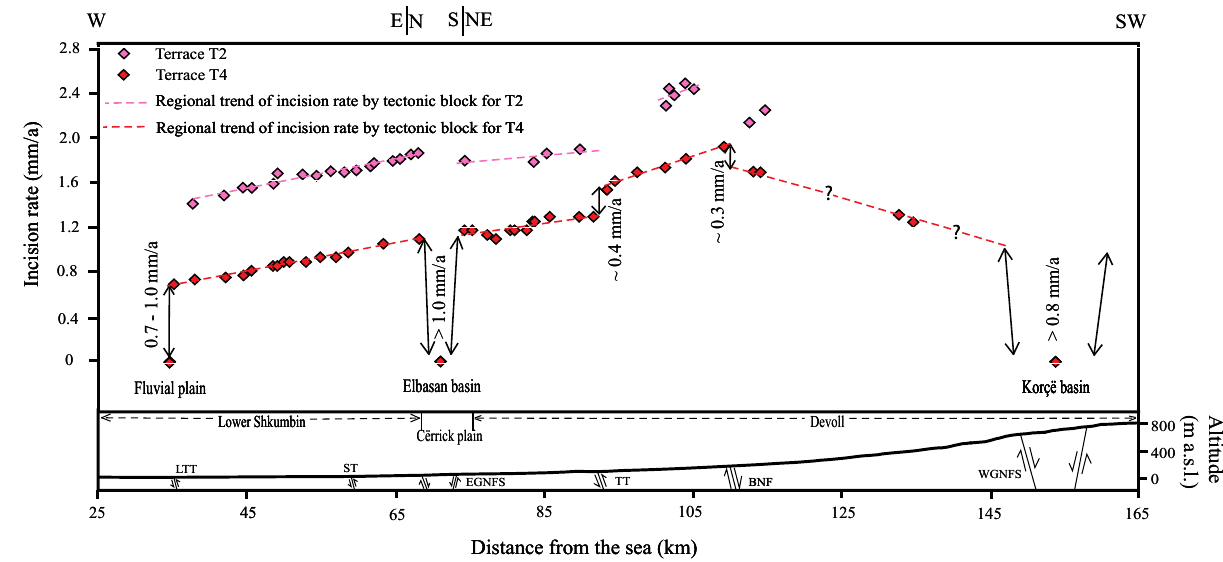
Figure 10. Evolution of the incision rate along the combined river profile of the lower Shkumbin and Devoll (Paleo-Devoll river). Left axis is the calculated incision rate; right axis is the elevation of the present-day river bed. Colour of the diamonds refers to the different terraces units. Into the lower box, appear the present-day river profile, on which are indicated the active faults. In the sedimentation zones (Fluvial plain, Elbasan and Korçë basins) the correlative deposits of terrace T4 are located in the present river-bed. In the river profile are located the Lushnje - Tepelenë Thrust (LTT),Shkumbin Trust (ST), Tomorrica Thrust (TT), the Burcal Normal Fault (BNF) and the West Graben Nor- mal Fault System